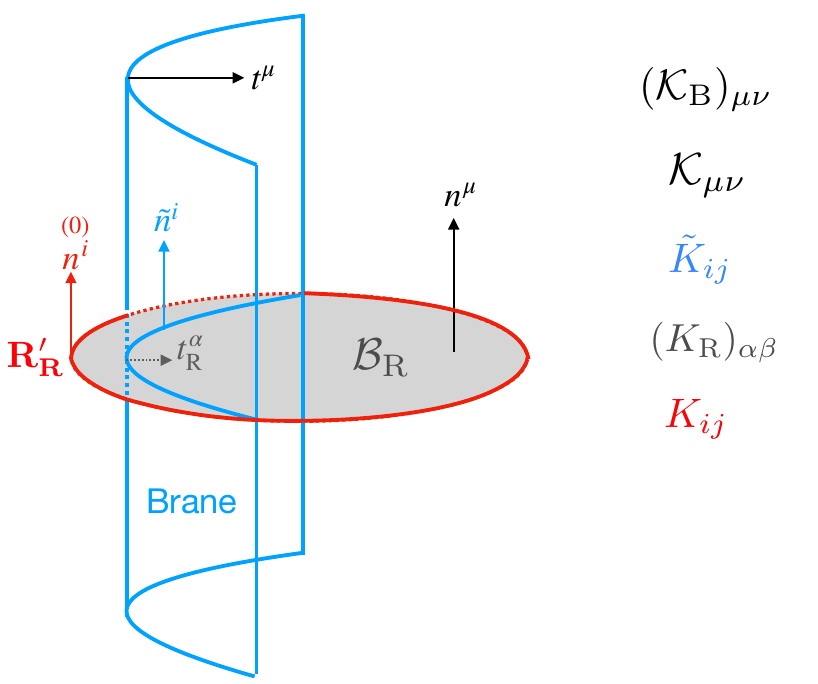
Figure 4 . Different hypersurfaces in the doubly holographic system and their corresponding ex- trinsic